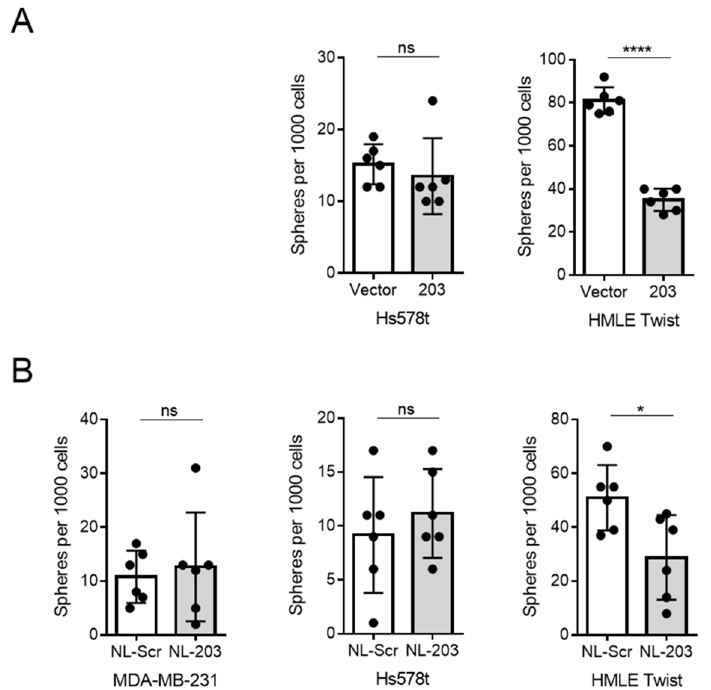
Figure 3. miR-203 is effective at inhibiting sphere formation in HMLE Twist cells, but not in triple negative breast cancer (TNBC) cell lines. ( A ) Sphere formation in indicated cell lines transduced with a retrovirus vector to stably overexpress miR-203. ( B ) Sphere formation in indicated cell lines exposed to microRNA mimic-loaded nanoliposomes at a concentration of 85 µ M for 48 h prior to plating for sphere formation. Biological replicates, mean and standard deviation are represented. p -value calculated for final measurement using Student’s two-tailed t -test. ns = not significant; * p < 0.05, **** p < 0.0001 .